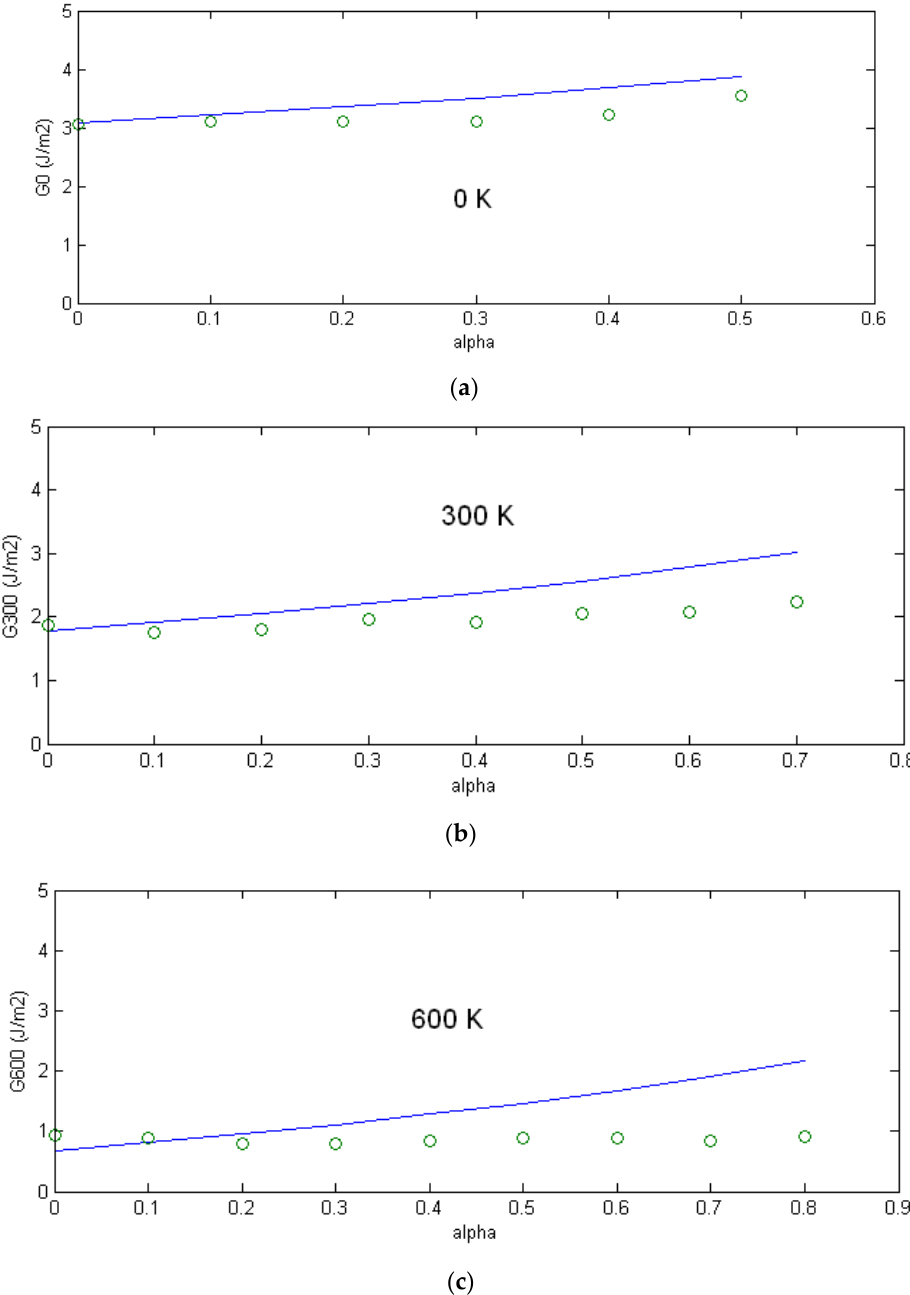
Figure 13. Comparison of the predicted G -values shown by the lines (–) with MD results denoted via circles (o) in dependence on biaxiality ratio α = σ B / σ A : ( a ) at temperature of ~0 K (G0); ( b ) at temperature of ~300 K (G300); ( c ) at temperature of ~ 600 K; the line is the prediction from [5] with γ us = 1.14 J / m 2 for the used potential.